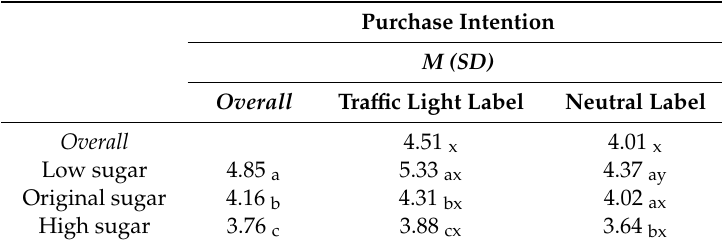
Table 7. Estimated marginal means of purchase intentions for products with low, original, and high sugar level in the tra ffi c light label and neutral label